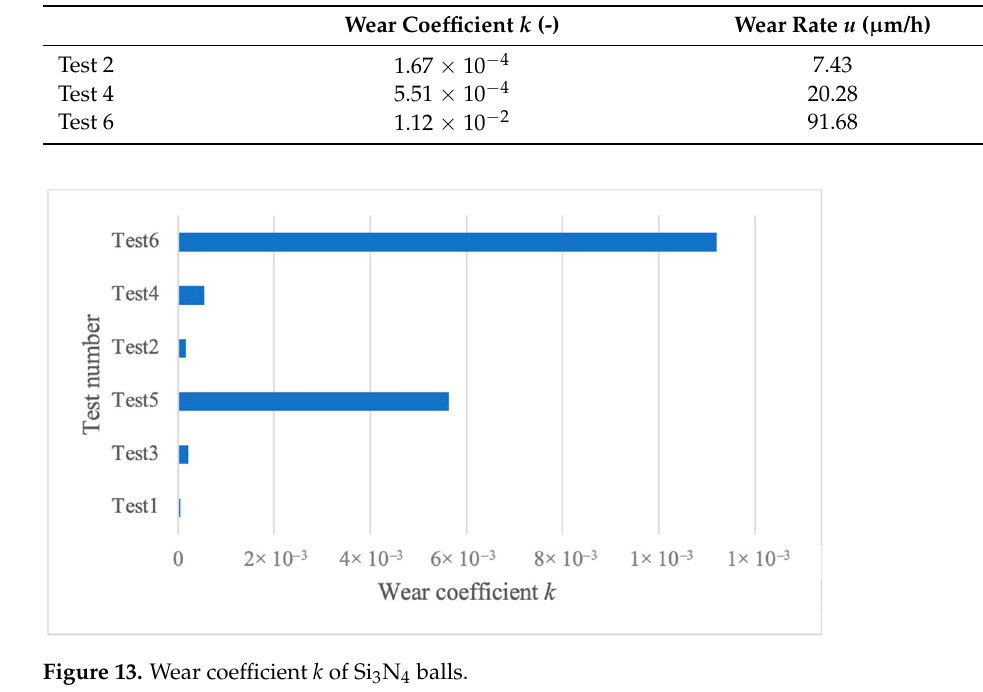
Table 12. Wear coefficient k and wear rate u of Si 3 N 4 ball for R t = 11 mm.